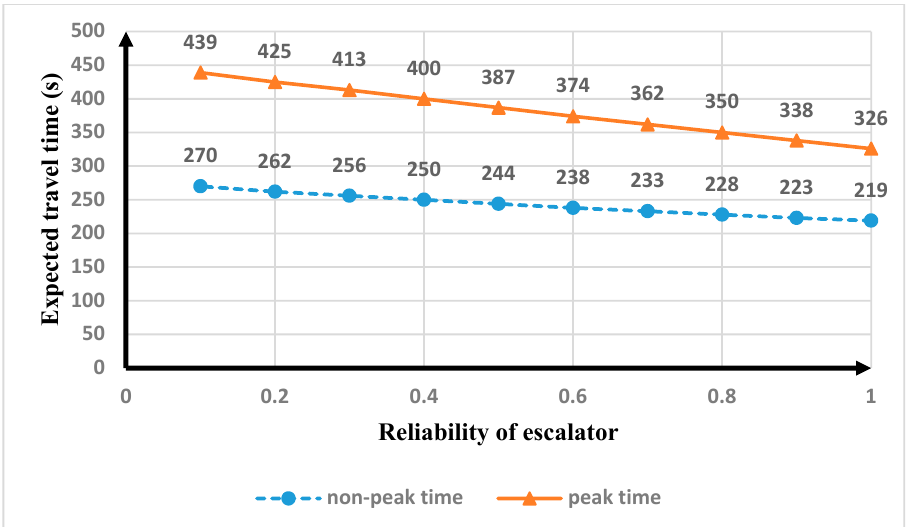
Figure 11. The impact of the reliability of the escalator on expected travel time.